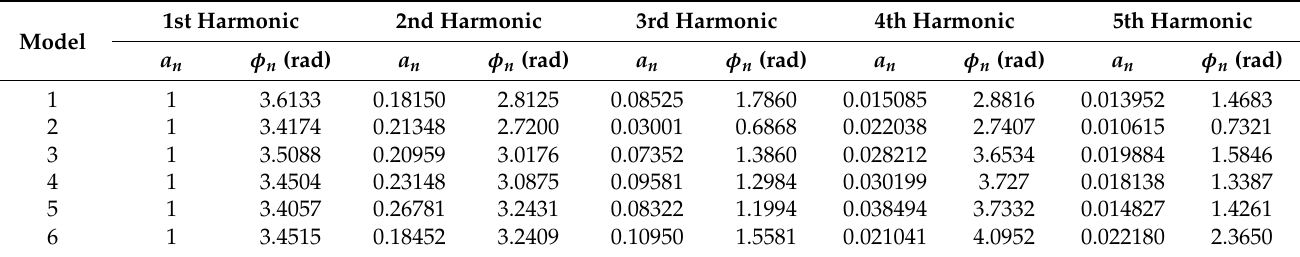
Table 1. Coefficients of harmonic models of the six most common thigh angle